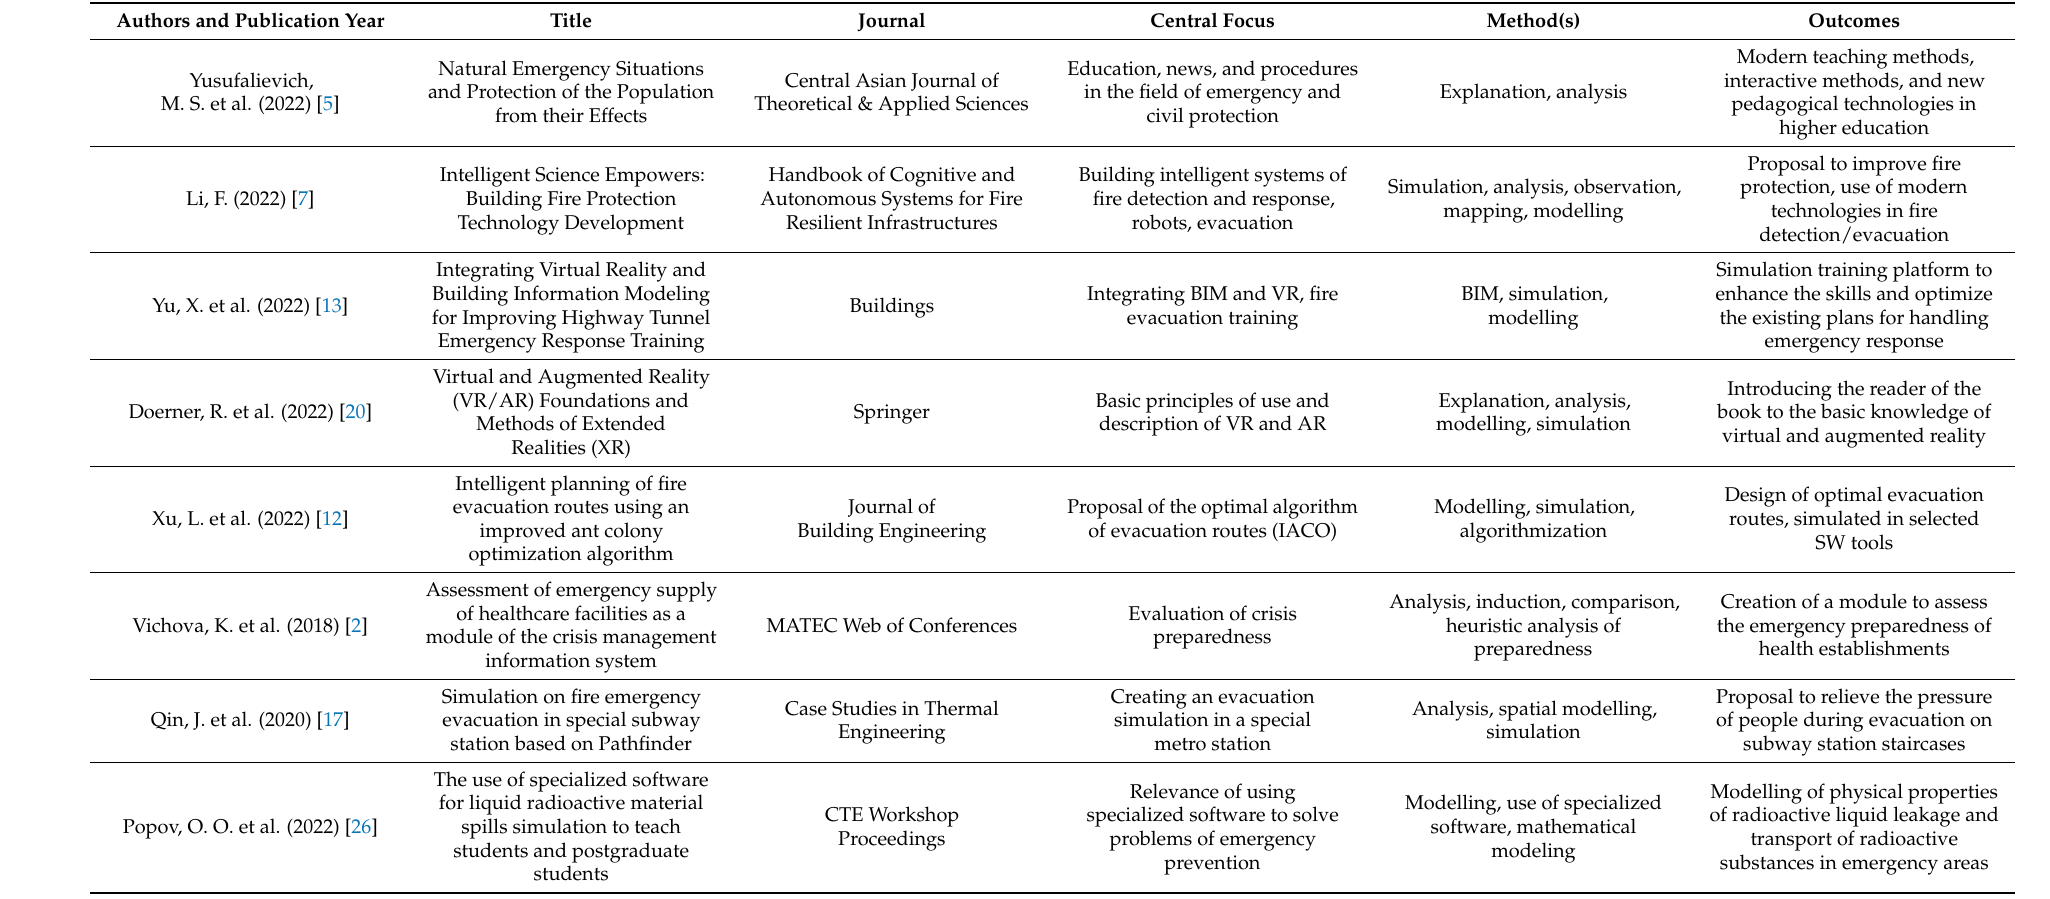
Table 5. Research studies on the Integrated Rescue System software